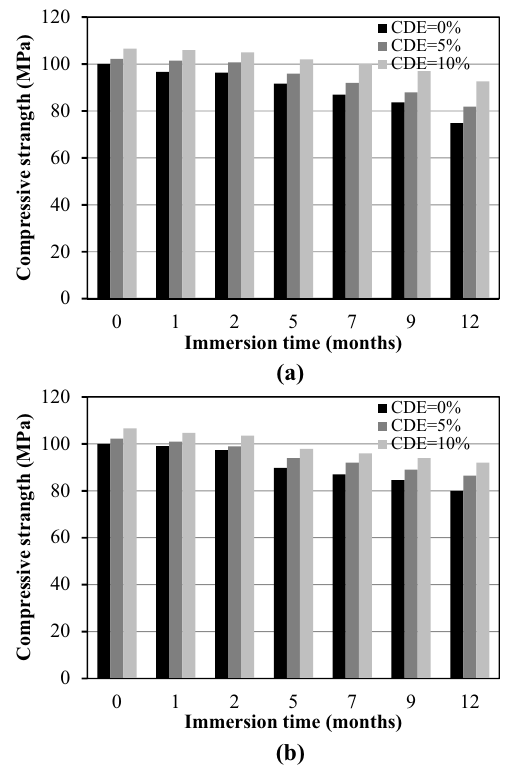
Figure 14: Compressive strength of UHPC after being immersed in: ( a ) NaCl and ( b ) Na 2 SO 4 solutions.